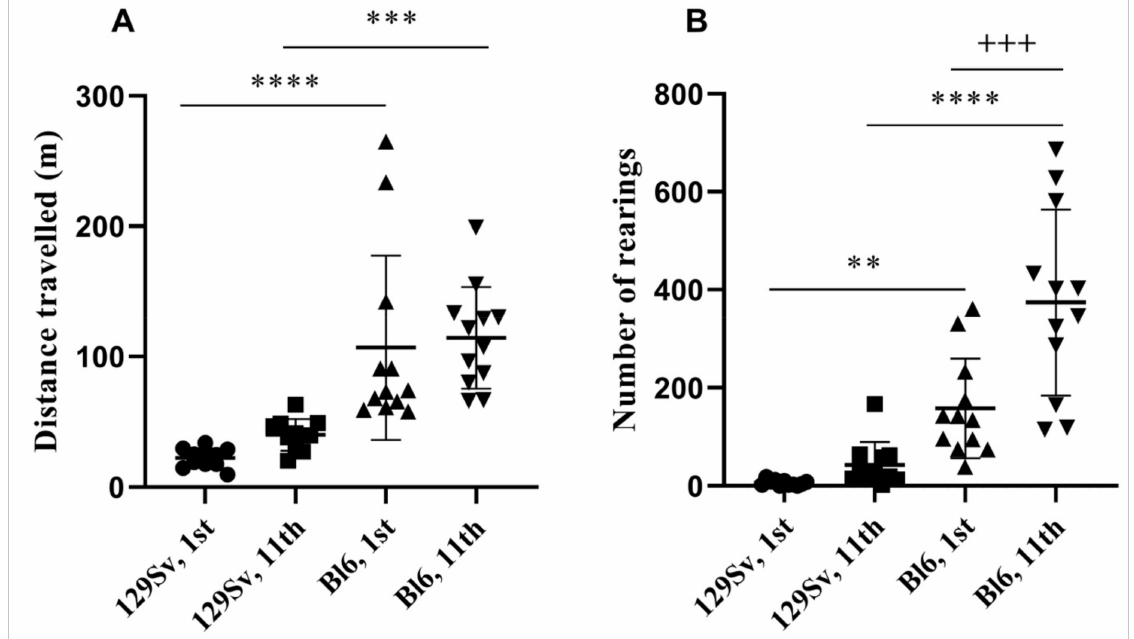
Figure 4. Changes in locomotor activity of Bl6 and 129Sv mice during repeated motility testing. Bl6 mice were more active both in terms of ( A ) distance travelled and ( B ) number of rearings. The difference in vertical activity between strains became augmented with each subsequent repeated testing. Data are presented as mean values ± SD. Bonferroni post hoc analysis after significant repeated measures ANOVA: ** p ≤ 0.01, *** p ≤ 0.001 and **** p ≤ 0.0001 compared to the respective 129Sv mice; +++ p ≤ 0.001 (compared to Bl6 on the 1st day of study). Number of animals in each group varied from 11 to